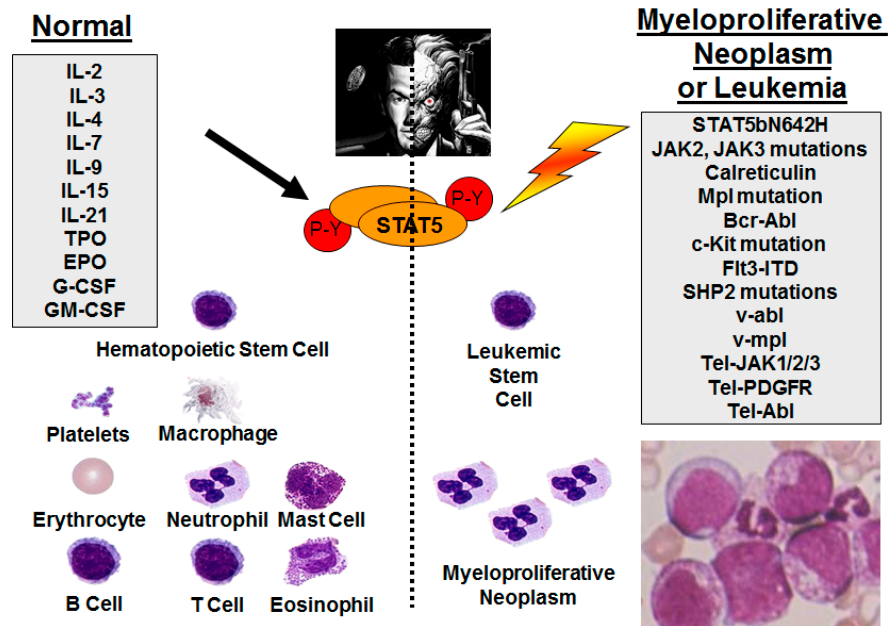
Figure 1. Signal transducer and activator of transcription-5 (STAT5) activation in normal and leukemic hematopoiesis—two faces of the same molecule. Different growth factors (left) normally activate STAT5 to drive hematopoietic differentiation in many lymphoid and myeloid lineages. In contrast, activating mutations (right), including some in STAT5b, result in persistent phosphorylation and transcriptional activation, which drives lymphoid and myeloid hematologic malignancies as well as myeloproliferative neoplasms.